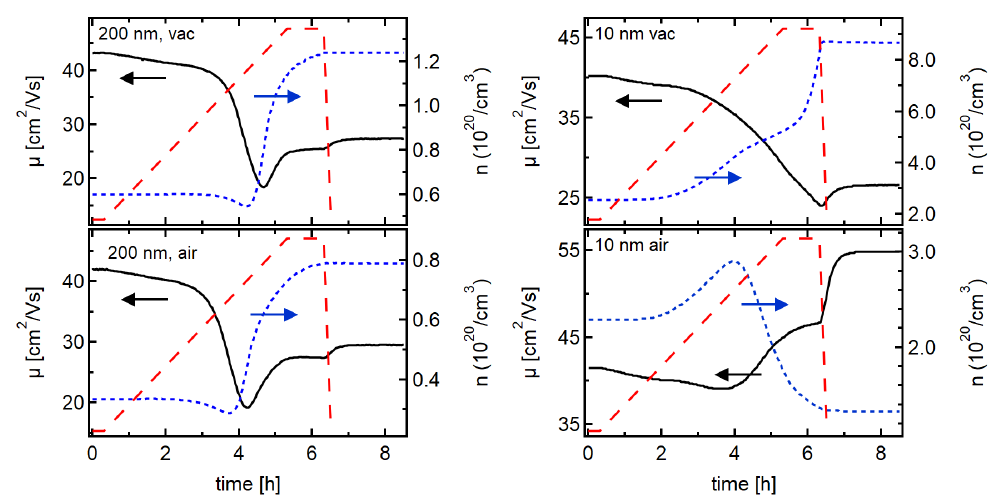
Figure 4. Hall effect measurements during annealing of 10 (right)and 200 (left) nm-thick ITO films deposited at room temperature in vacuum (top) or in air (bottom). The red dashed lines show the programmed temperature with a controlled heating ramp from 25–200 ◦ C and a holding time of 1h at 200 ◦